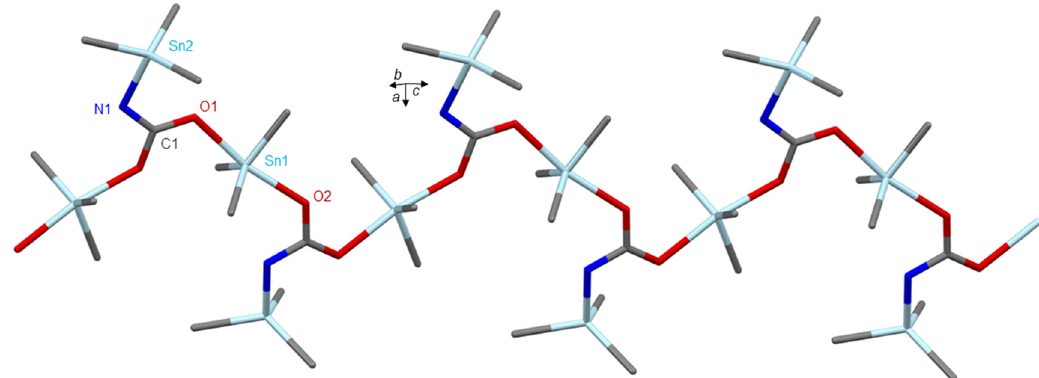
Figure 1. Molecular structure of 1 , adapted from [42] (MERCURY view). Hydrogen atoms are omitted for clarity (Sn light blue, O red, N dark blue, C grey).